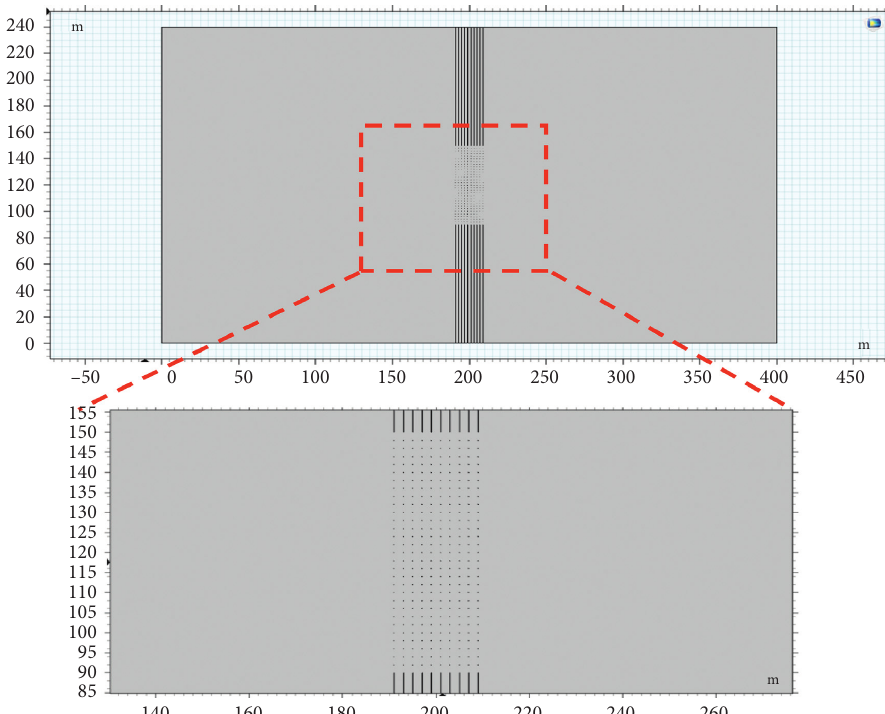
Figure 3: Borehole layout method for gas drainage combined with long boreholes along the seam and penetrating